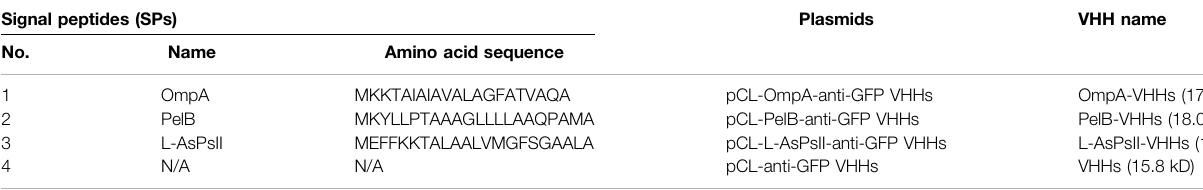
TABLE 1 | Amino acid sequence of signal peptides used in this study. Signal peptides (SPs)